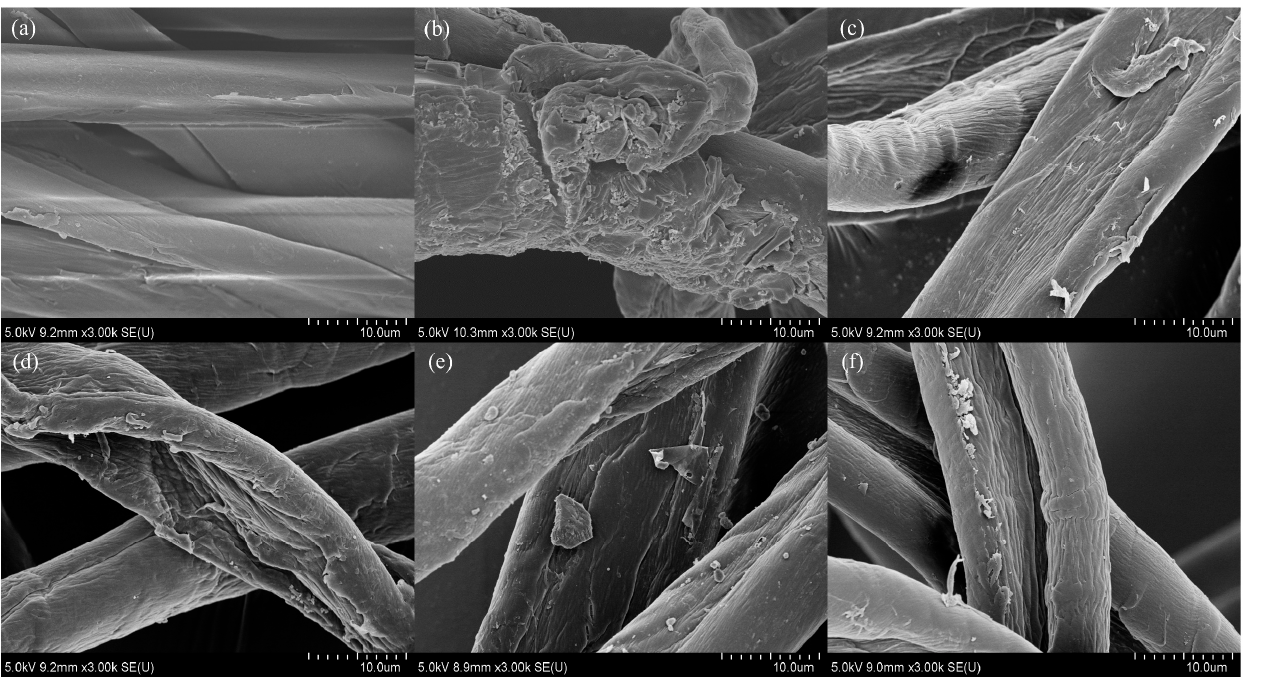
Figure 2. Scanning electron micrographs of textile waste (cotton/PET 60/40) before pretreatment ( a ) and after pretreatment with reusable NaOH with first cycle ( b ), second cycle ( c ), third cycle ( d ), fourth cycle ( e ), and fifth cycle ( f ) at a magnification of 3000×.